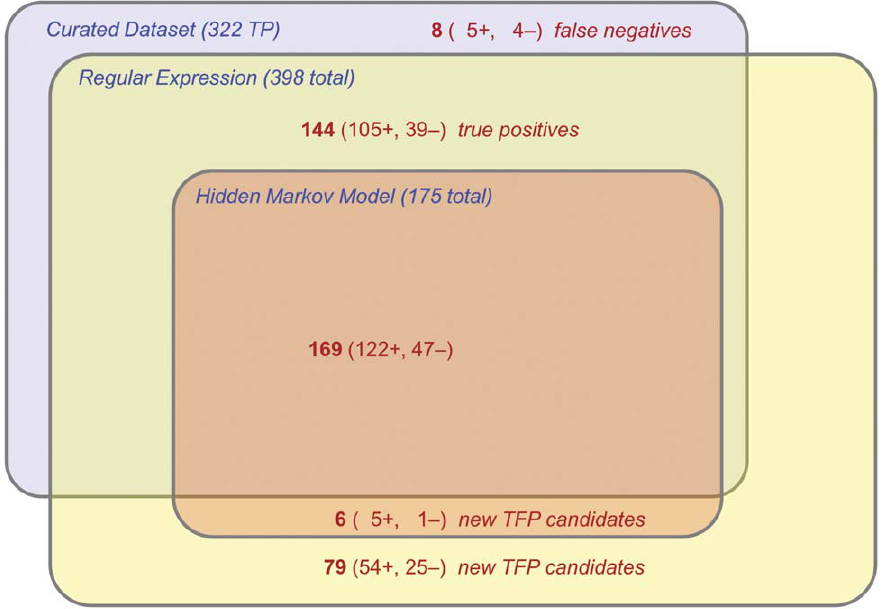
Figure 6. Comparison of type IV pilin predictions using Hidden Markov Model (HMM)- and regular-expression (RE)-based approaches. Venn diagram indicating the total number of type IV pilins predicted in 48 genomes (38 Gram-positive and 10 Gram-negative) using an HMM, a RE, or manual curation. The HMM approach displays high specificity, but is only capable of identifying a relatively small subset of the curated type IV pilins (106 of 218), and 24 new pilin candidates. The RE-based approach identified a much larger number of curated type IV pilin (210 of 218), along with 110 new pilin candidates, including all those of identified by the HMM-based approach, respectively. Numbers in parenthesis indicate data for the True Positive ‘‘ + ’’, and False Negatives ‘‘ 2